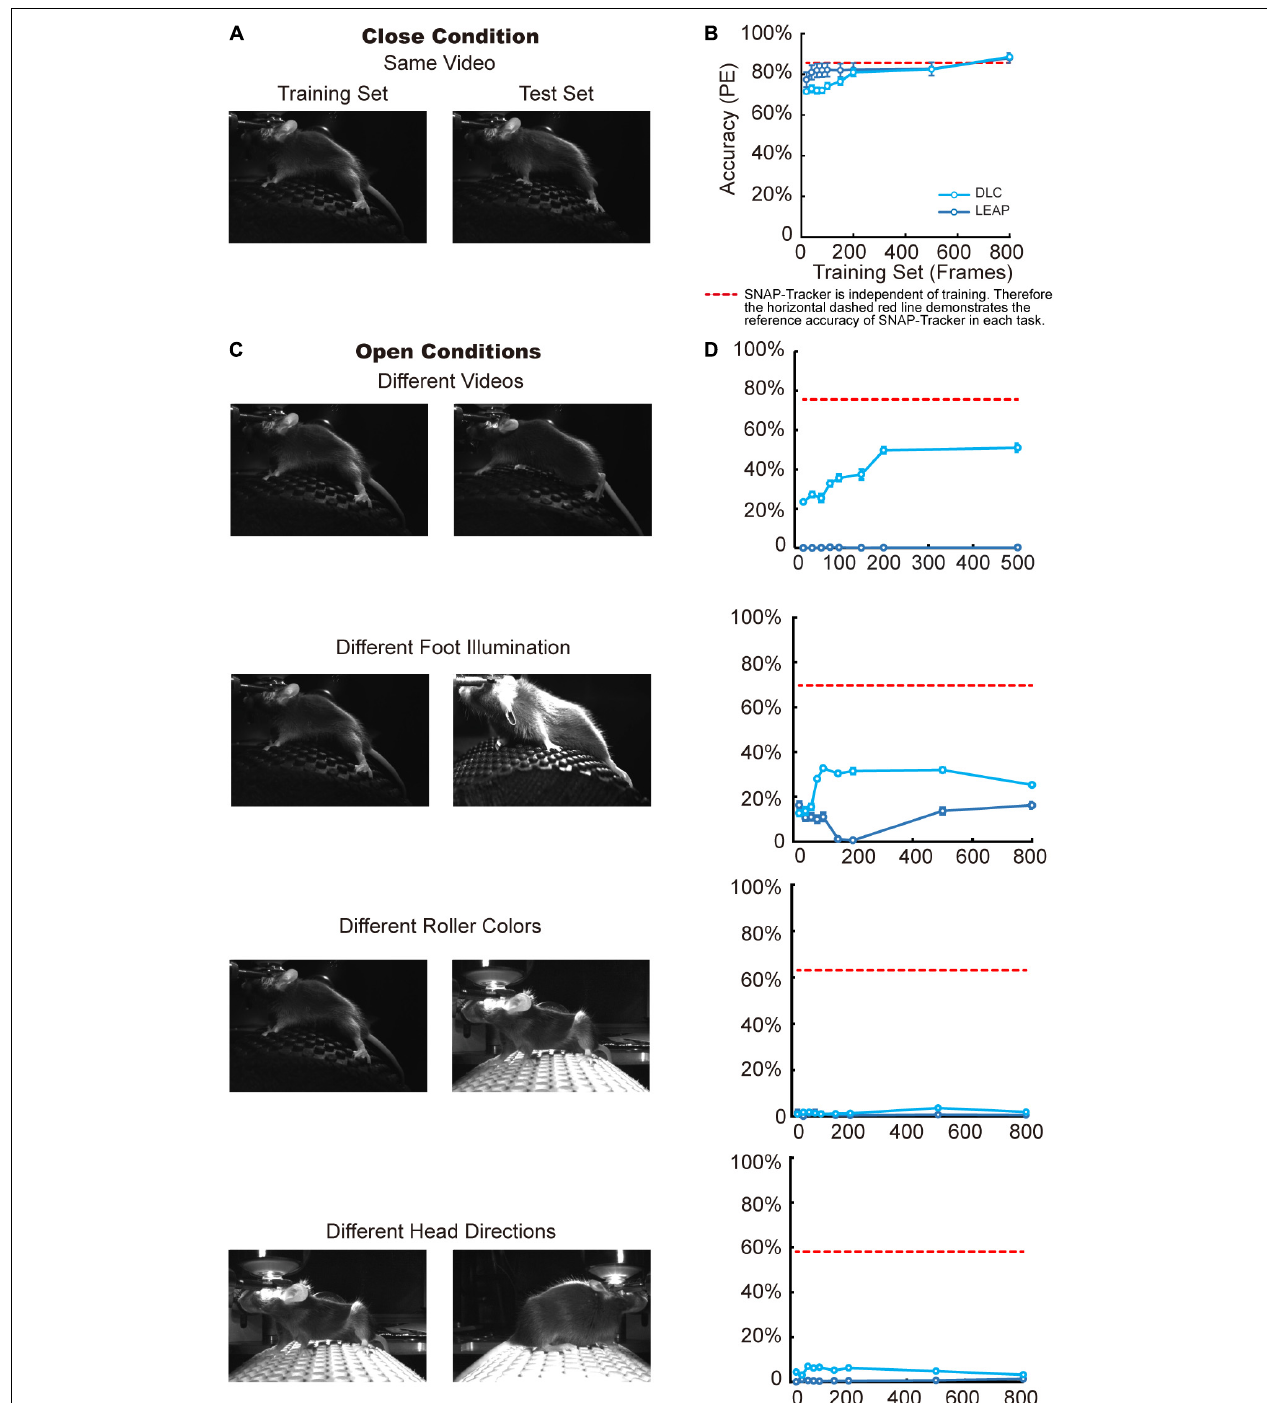
FIGURE 3 | Stable performance of SNAP-Tracker in open conditions. (A) In the close condition, training and test frames come from the same video. (B) The accuracy of three methods in the close condition with different scales of the training set. The tracking accuracy of DLC (dare blue) and LEAP (light blue) increases with more training frames. SNAP-Tracker (red) is independent of training, and its performance is comparable to the other two. Accuracy: the ratio of frames with PE value lower than the threshold of 20 pixels. (C) In four kinds of open conditions, the test video can be a different one with similar environmental conditions (the first row) or has different illumination (the second row), different roller colors (the third row), different head directions (the last row). (D) In open conditions, the accuracies of DLC and LEAP both drop significantly even trained with the highest number of training frames. However, SNAP-Tracker can still keep relatively good performance due to its independence to